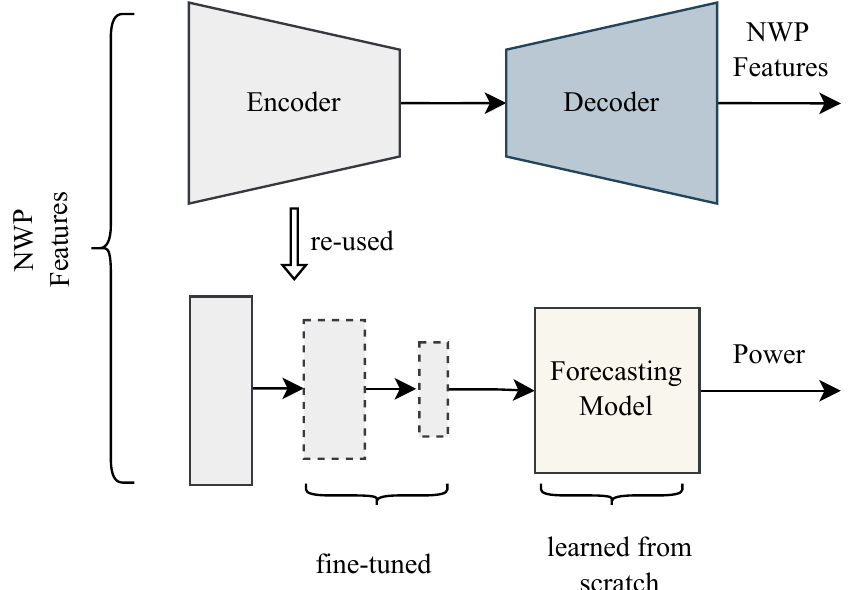
Figure 8. In our experiments, we initially trained an autoencoder to reconstruct the NWP features and learn the latent features of the weather. Afterward, the encoder was fine-tuned with a forecasting model to forecast the day-ahead